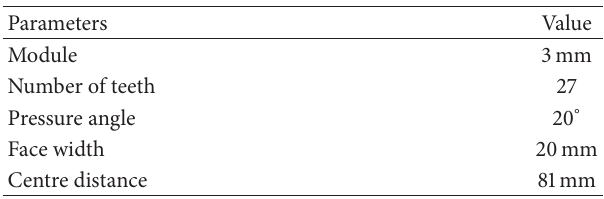
Table 1: Spur gear specifications.